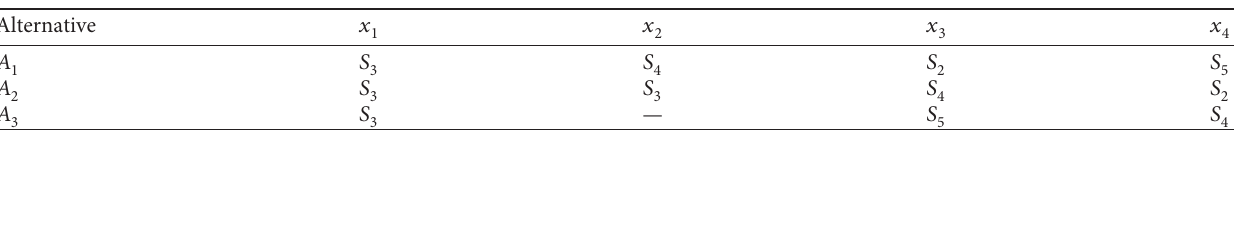
Table 26: The probabilistic linguistic decision matrix of the group.